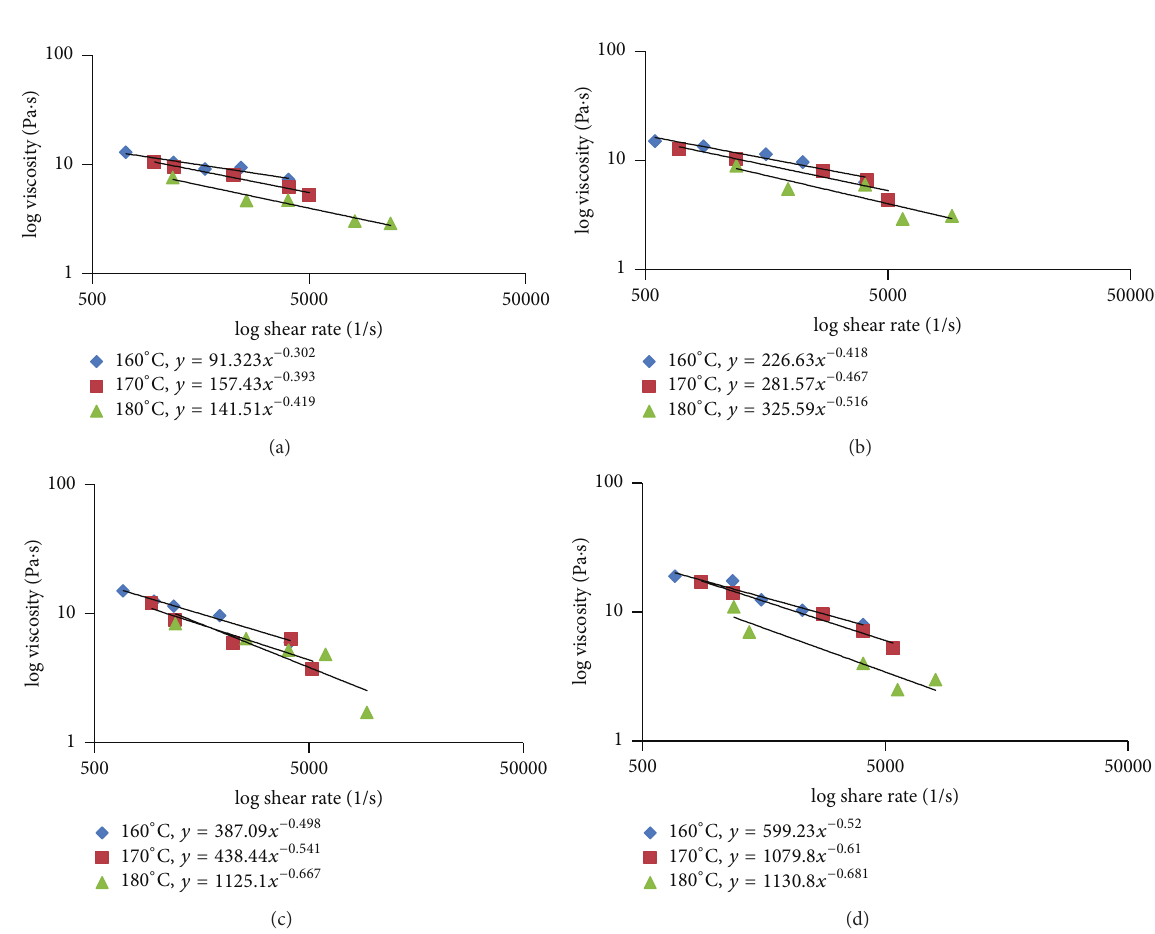
Figure 6: Viscosity results for (a) PWA-0B, (b) PWA-0.5B, (c) PWA-1B, and (d) PWA-1.5B feedstocks.